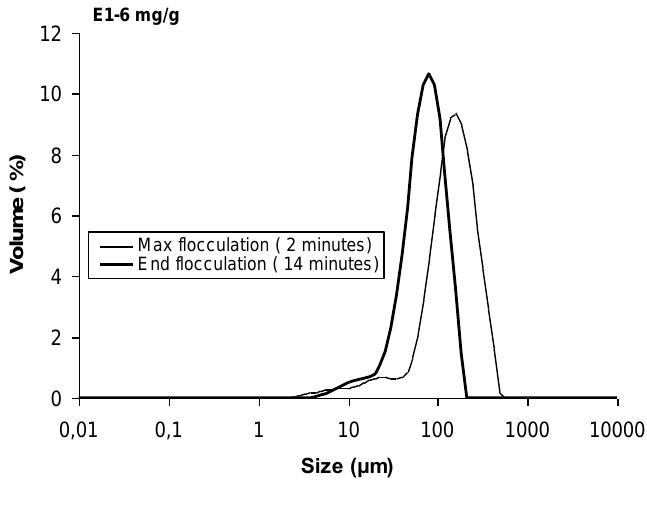
Figure 3. Particle size distribution of the flocs obtained with E1 (6 mg/g) at two different instants (2 and 14